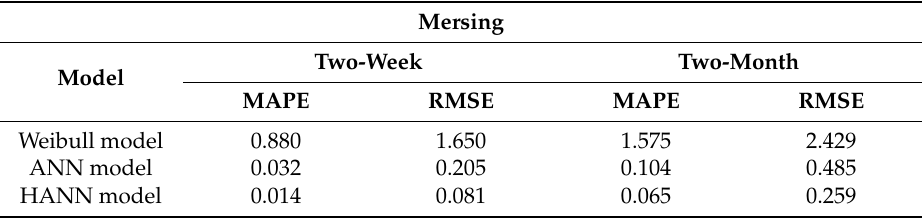
Table 4. Statistical errors generated by the Weibull model, ANN model, and HANN model.